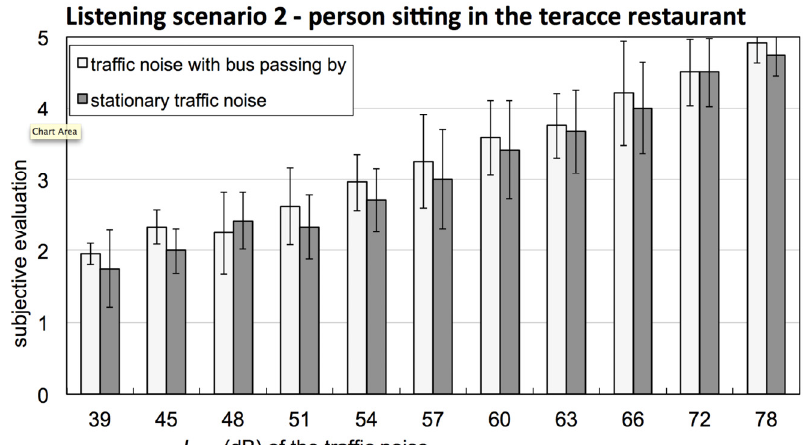
Figure 7. Listening scenario 2: Results given as average values + standard deviation. The subjective evaluation was defined as: 1—too silent, 2—pleasant, 3—acceptable, 4—noisy or